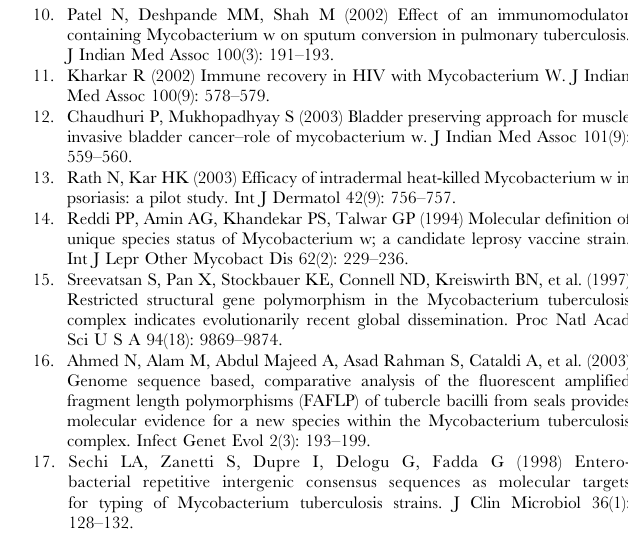
Figure S1 Phylogenetic trees based on comparison of the DNA sequences corresponding to gyrB gene (A) and 32kDa protein gene (B) of MIP and other mycobacteria. Sequence alignment was performed in Clustal W software and phylogenetic trees were developed in MEGA3.1 using bootstrapping method. Found at: doi:10.1371/journal.pone.0000968.s001 (0.11 MB PPT) Figure S2 Alignment of gyrB of MIP with other members of MAIC complex (M. avium and M. intracellulare) Found at: doi:10.1371/journal.pone.0000968.s002 (0.15 MB PPT) Figure S3 Alignment of 32kDa protein gene of MIP with other members of MAIC complex (M. avium and M. intracellulare). The identities are depicted by dots